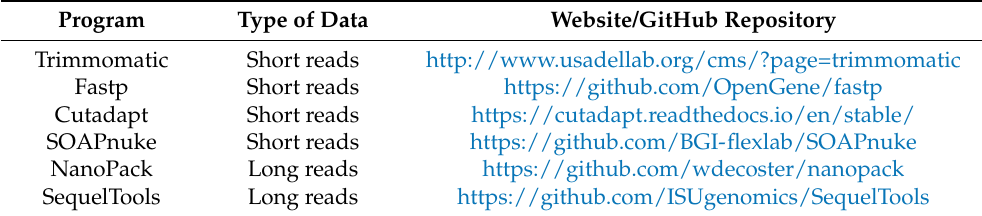
Table 2. Bioinformatic programs for data trimming in short-read and long-read sequencing. All websites/GitHub Repository links were accessed on 23 December